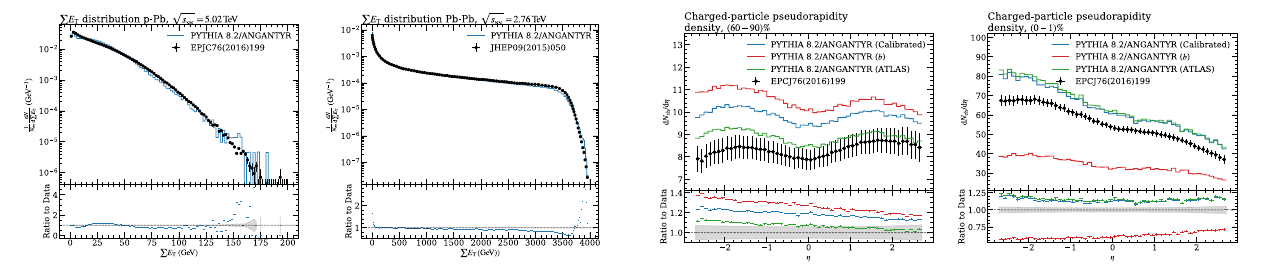
√ = 2 . 76TeV [41] (right), compared to s NN